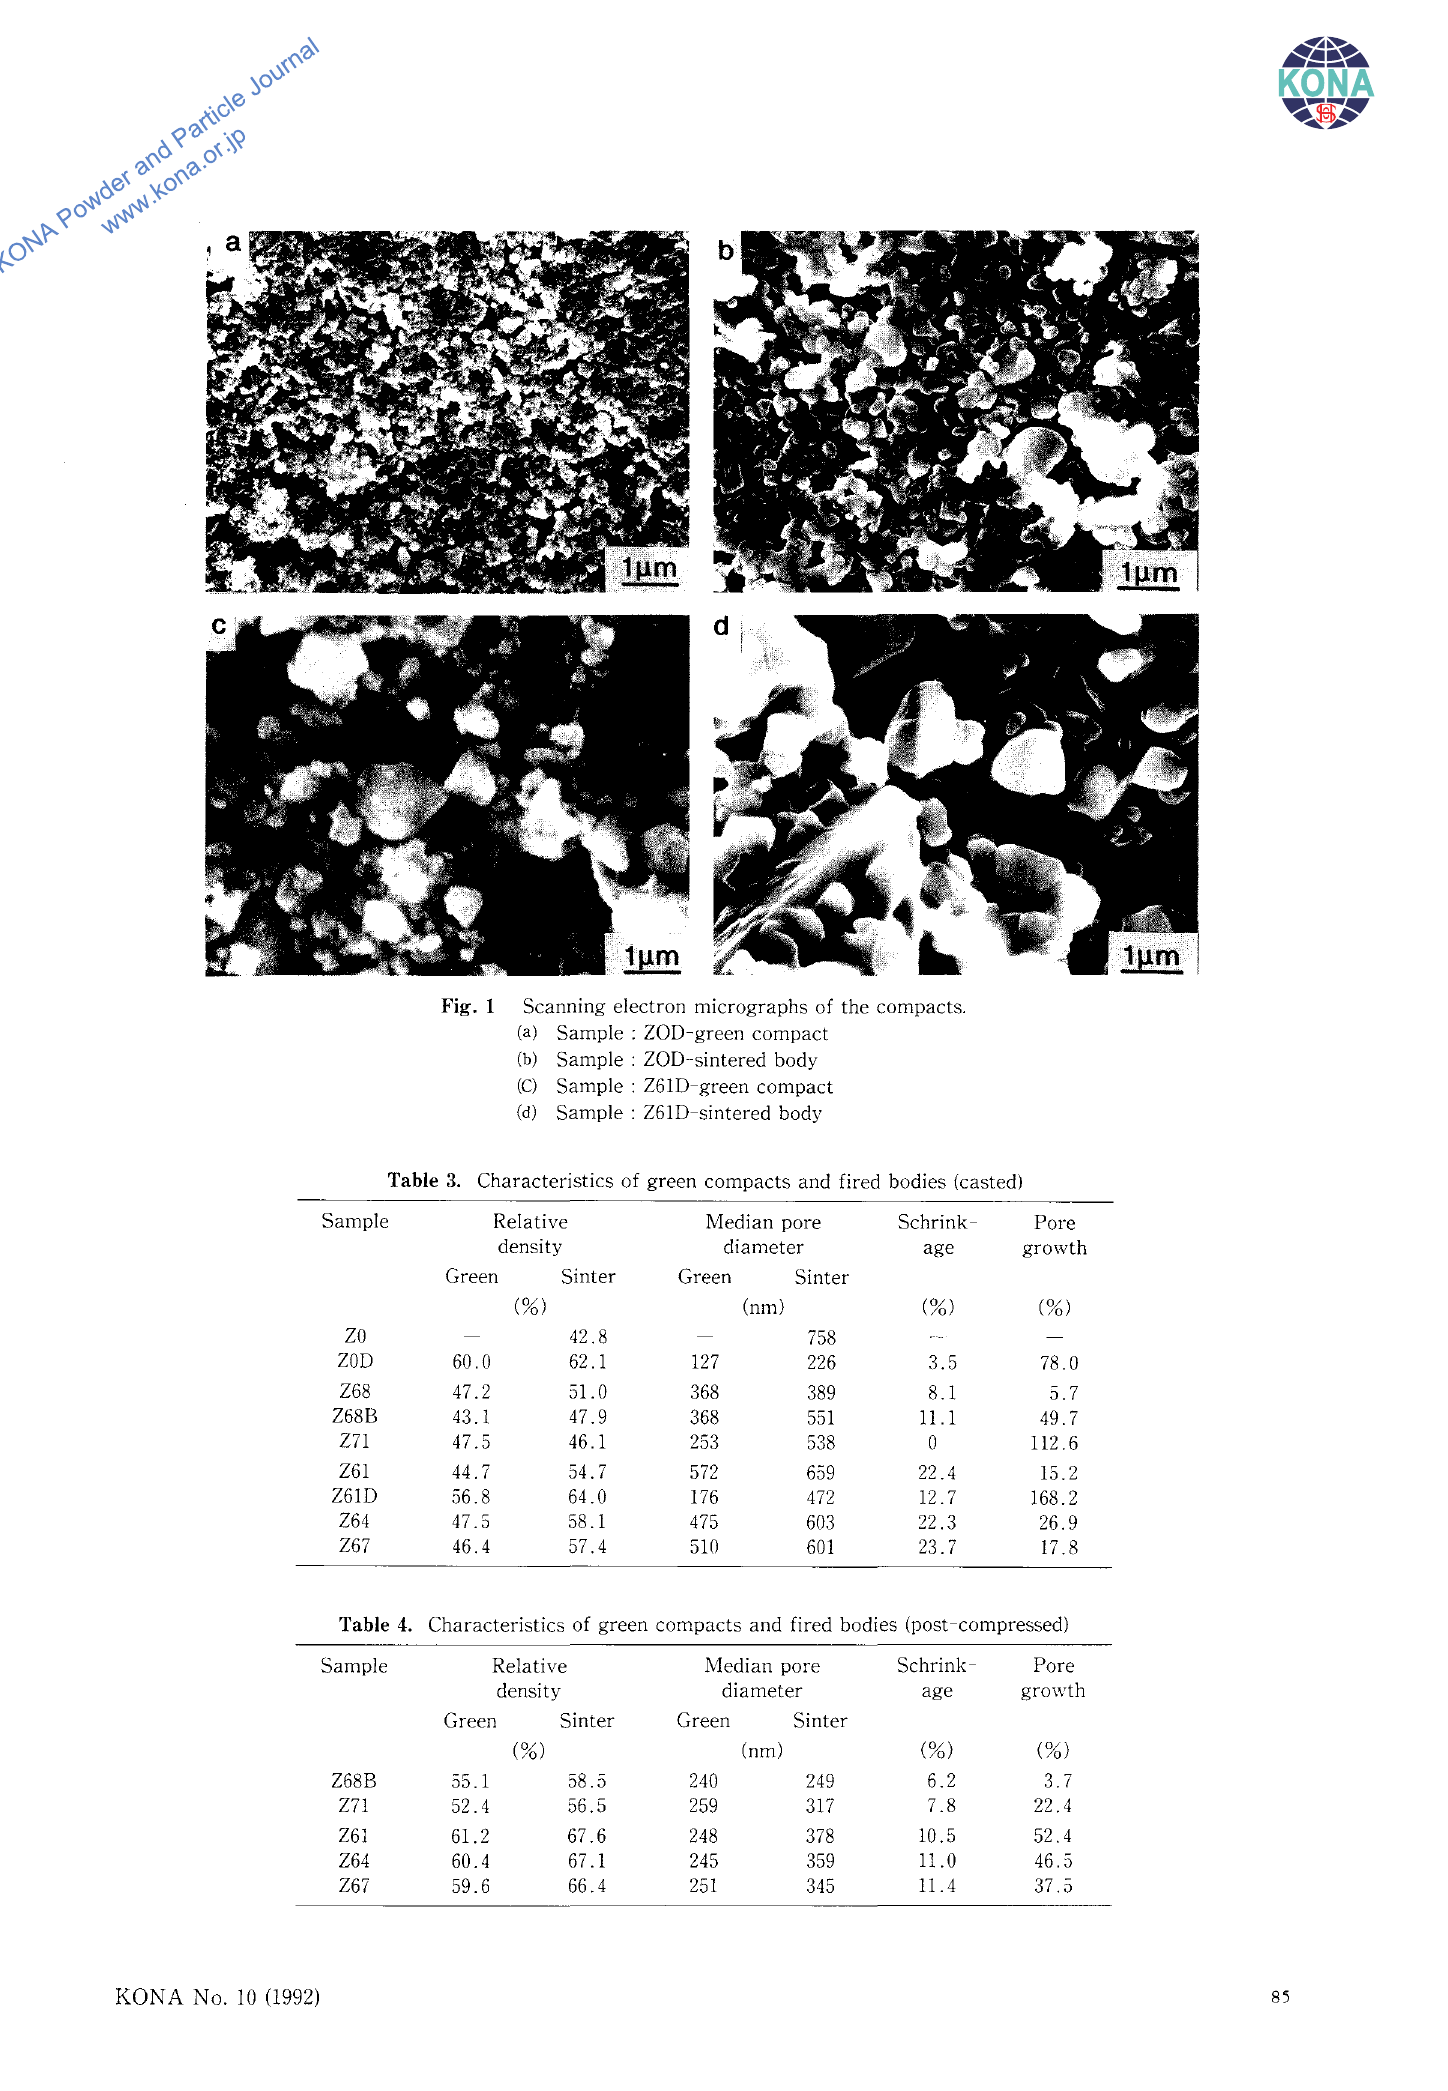
Table 3. Characteristics of green compacts and fired bodies (casted)